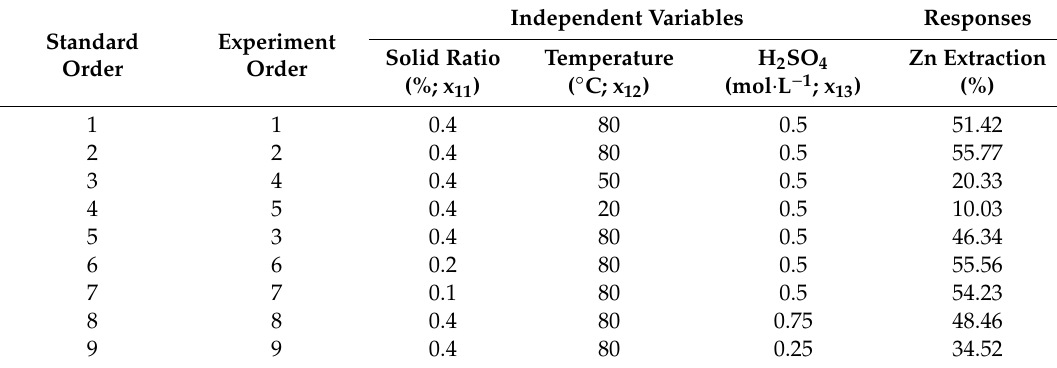
Table 4. Experiment conditions and responses of stirred-tank reactor tests.